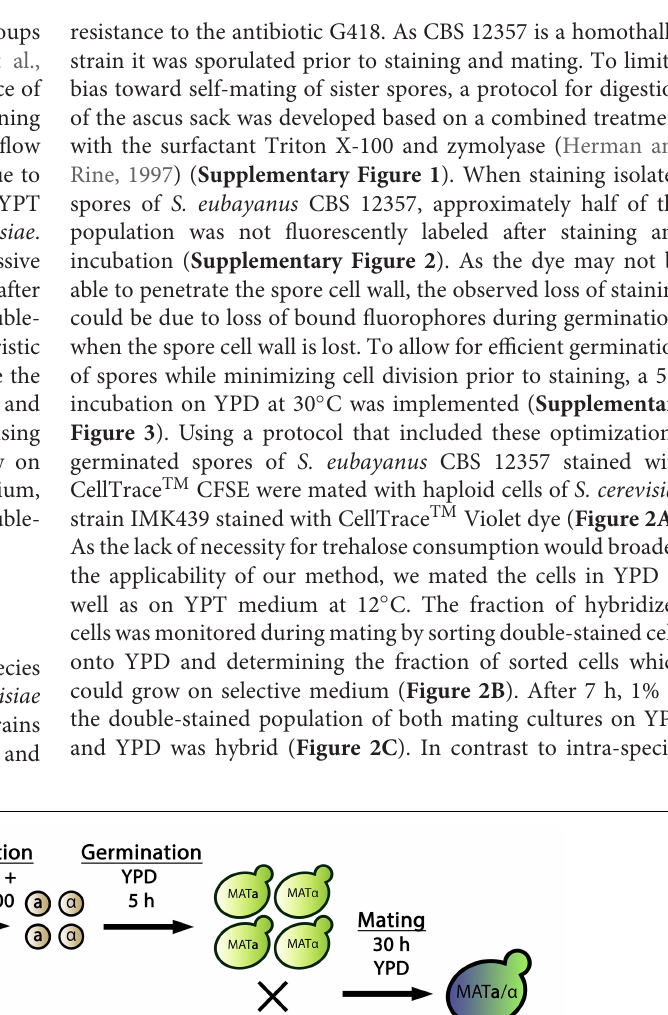
Frontiers in Microbiology |